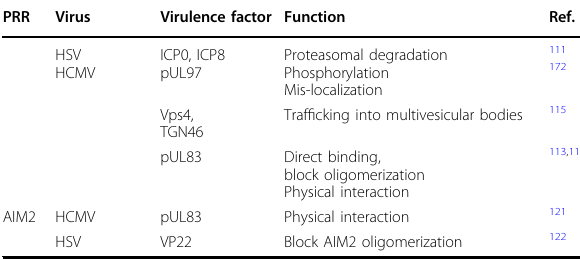
Table 3 Viral evasion mechanism for RNA and DNA virus